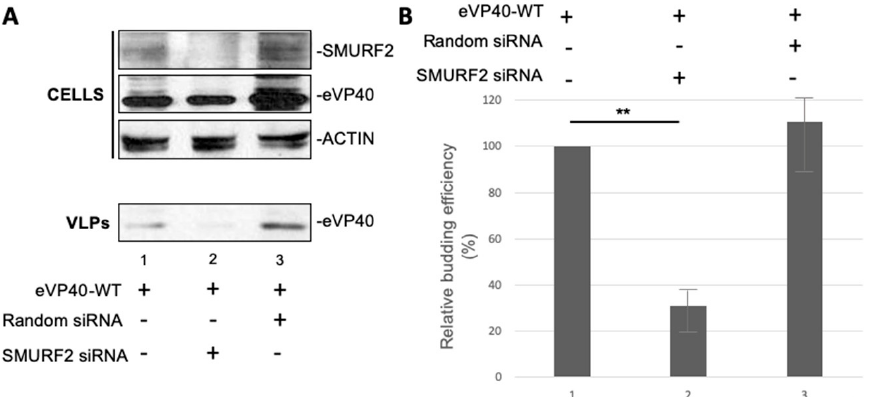
Figure 6. SiRNA knockdown of SMURF2 decreases VP40 VLP budding efficiency. ( A ) HEK293T cells were transfected as indicated and the indicated proteins were detected in cell extracts and VLPs by Western blotting. ( B ) Graphical representation of the relative budding efficiency of eVP40 under the indicated conditions from three independent experiments; student t test, ** = p <0.005.